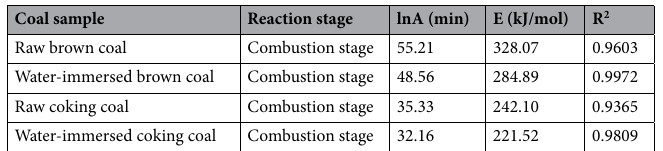
Table 4. Fitting parameters of brown coal and coking coal oxidation kinetics before and after water-immersed.